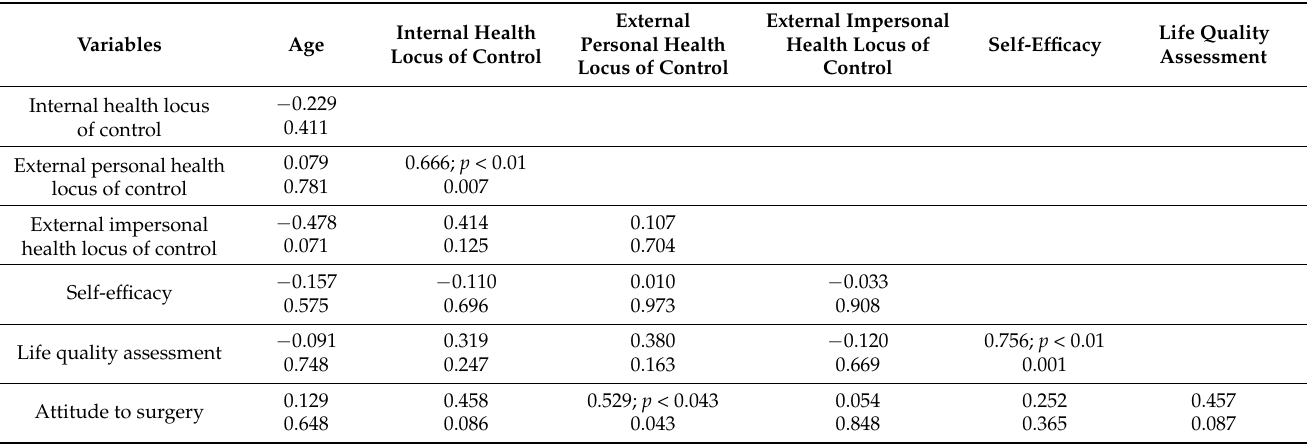
Table 2. Correlations between attitude to surgery, age, and the selected constituents of personal resources in ICAS female